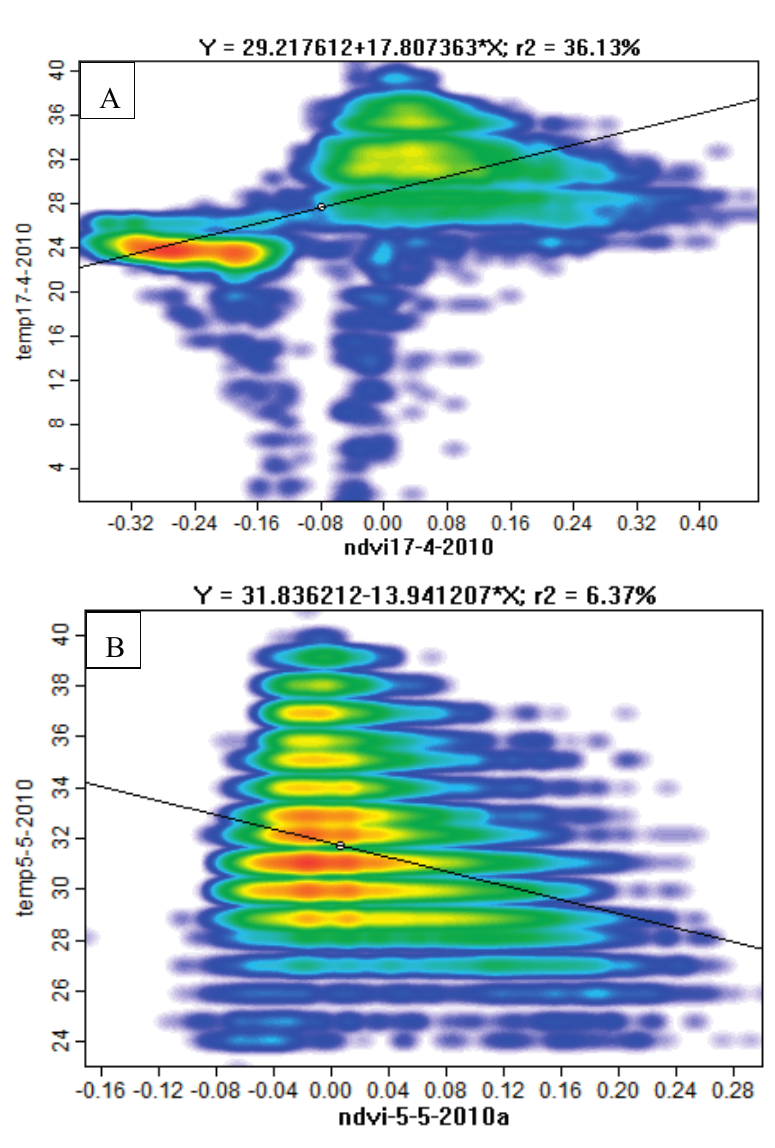
Figure 3. Regression analysis of LST and NDVI, where NDVI is the independent and LST is the dependent variable. ( A ) Scatter plot for Mumbai and ( B ) for